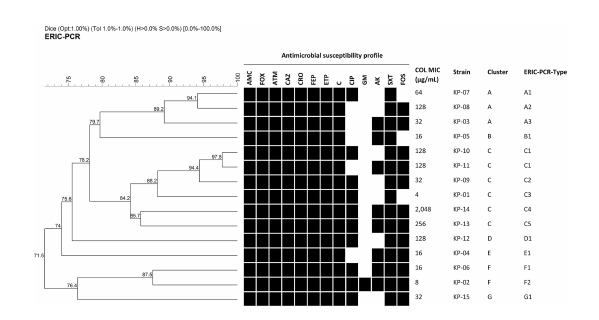
FIGURE 1 Dendrogram of genetic similarity generated by ERIC-PCR among fi fteen MDR/XDR K. pneumoniae clinical isolates. Strain information showing antimicrobial susceptibility pro fi les, colistin MIC, cluster, and ERIC-PCR types. Black squares represent isolates that were resistant or intermediate to antimicrobial agents. Antimicrobial agents are abbreviated as follows: AMC, Amoxicillin/clavulanic acid; FOX, cefoxitin; ATM, aztreonam; CAZ, ceftazidime; CRO, ceftriaxone; FEP, cefepime; ETP, ertapenem; C, chloramphenicol; CIP, cipro fl oxacin; GM, gentamicin; AK, amikacin; SXT, trimethoprim/sulfamethoxazole; FOS, fosfomycin; and COL, colistin.